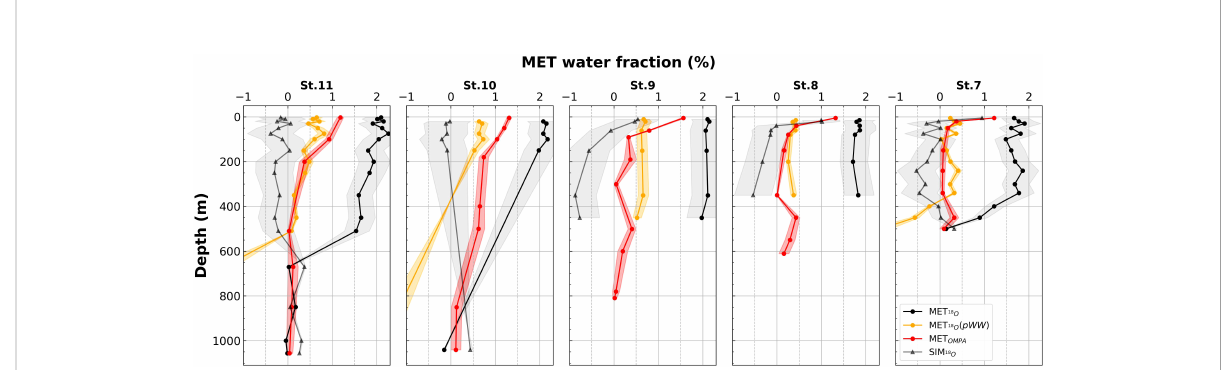
FIGURE 6 Comparison of MET fractions calculated by the NG-OMPA (MET OMPA = SMW + VMW) and d 18 O methods. The MET fractions calculated using the d 18 O method with mCDW as a source water, in addition to SIM and MET, are shown in black. If pWW, instead of mCDW, is considered as a source water, the differences in the fractions calculated by the d 18 O (shown as orange lines) and NG-OMPA methods (shown as red lines) become smaller. SIM 18O are the fraction of sea ice meltwater calculated using d 18 O method. Negative fractions of SIM 18O indicate sea ice